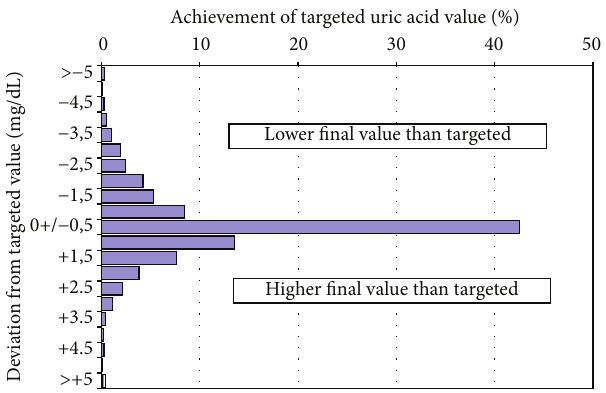
Figure 2: Percentage of patients who reached the individual target value of 6mg/dL (0 ± 0.5 mg/dL), respectively, who had lower ( − 1 to > − 5 mg/dL) or higher (+1 to > +5mg/dL) uric acid values. Note that about one-third (29.6%) failed to reach the guideline recommended target [6,